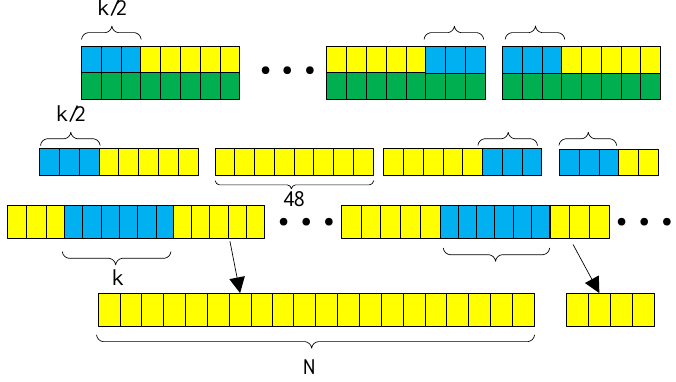
Figure 6. Block extraction of covert